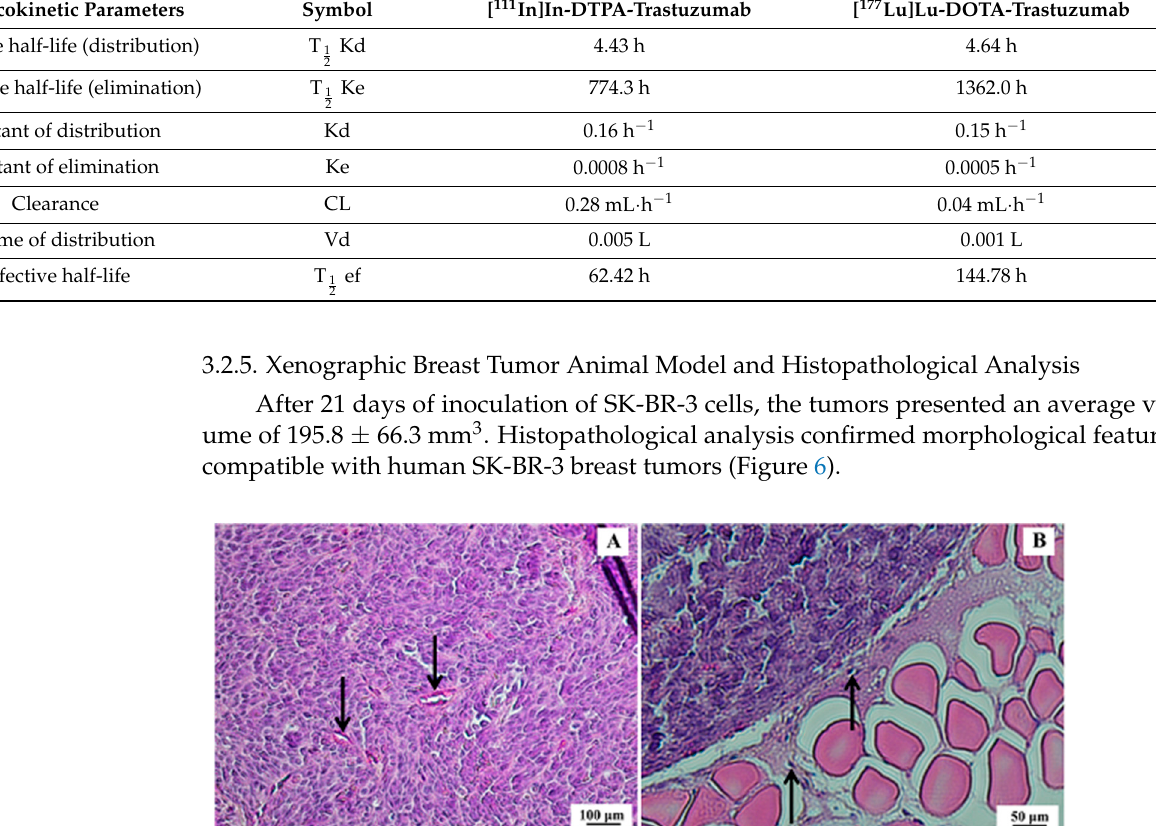
Figure 5. Percentage curves of the activities of the RICs, [ 111 In]In-DTPA-trastuzumab and [ 177 Lu]Lu-DOTA-trastuzumab, in total blood of normal female BALC/c mice. Values are expressed as mean ± SEM ( n = 4–5). Table 1. Pharmacokinetic parameters of [ 111 In]In-DTPA-trastuzumab and [ 177 Lu]Lu-DOTA-trastuzumab determined in normal female BALB/c mice ( n = 4–5).